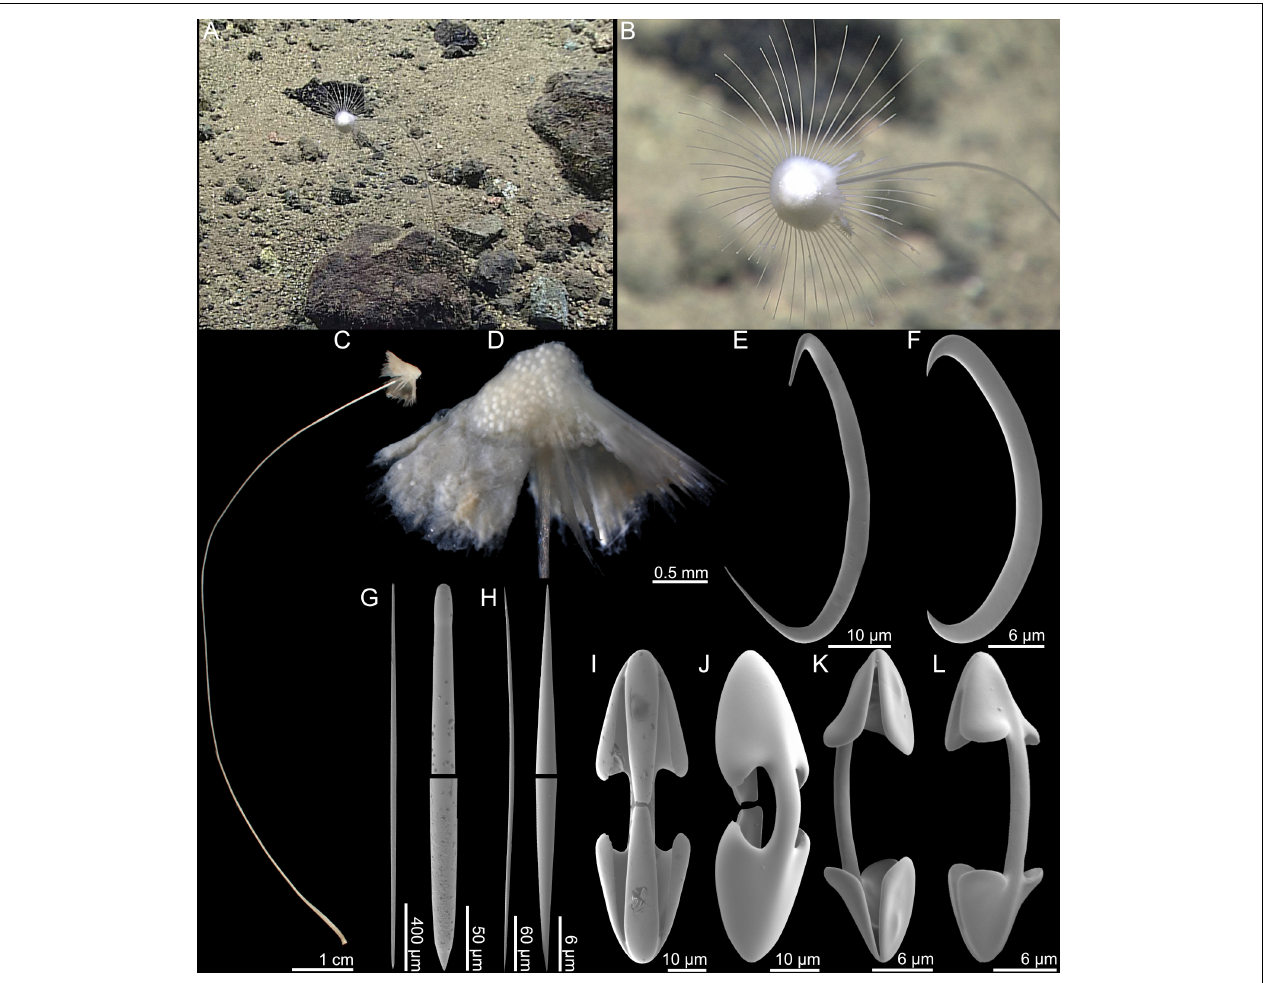
FIGURE 4 | Abyssocladia marianensis n. sp. (A,B) In situ images from ROV feed, (C) whole specimen, (D) detail of body, (E) sigmancistra 1, (F) sigmancistra 2, (G) mycalostyle with faint tyle, (H) oxea, (I) cleistochela front view, (J) cleistochela back view, (K) palmate chela front view, and (L) palmate chela back view.